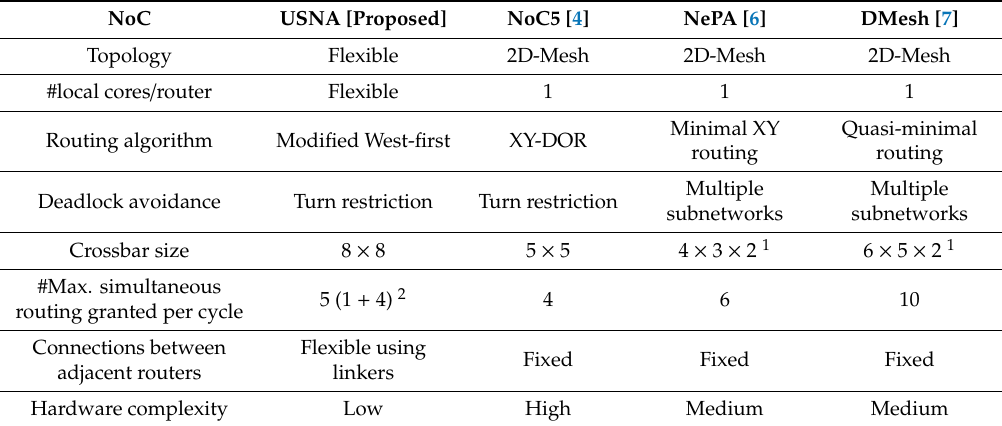
Table 1. Comparison of various NoC